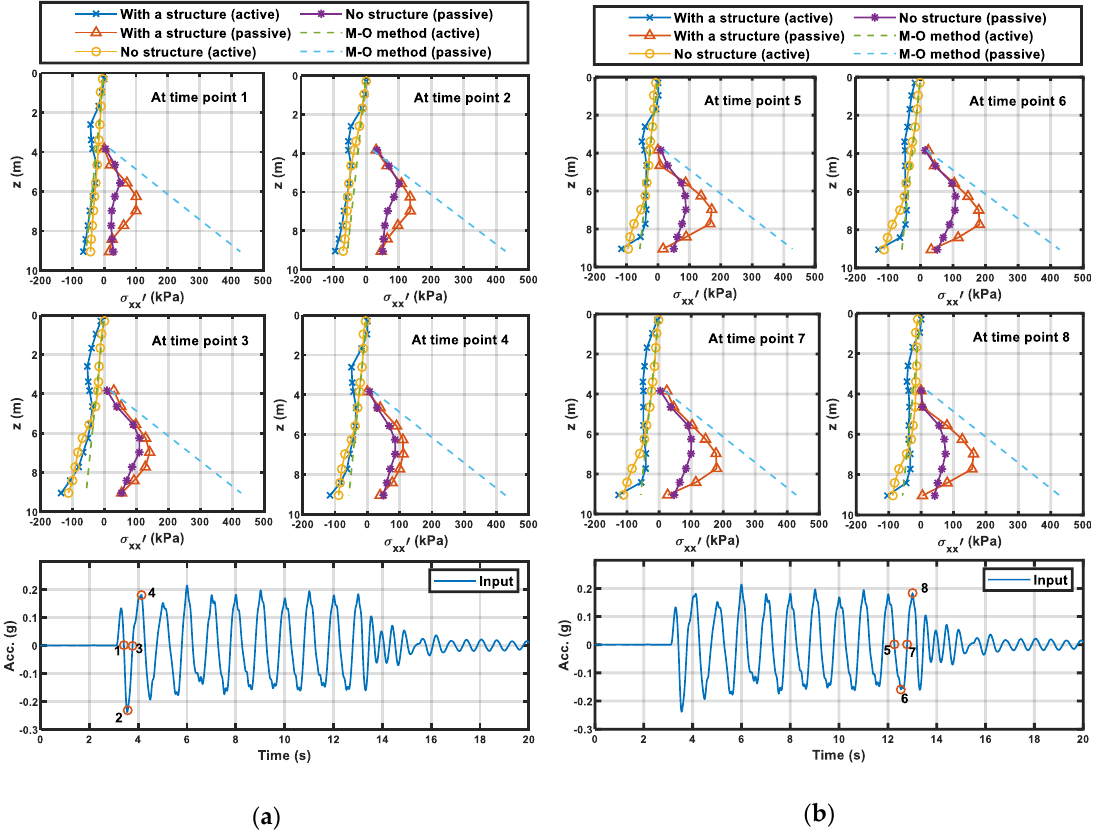
Figure 17. Evolution of the horizontal earth pressures through: ( a ) an earlier earthquake loading cycle and ( b ) a later earthquake loading cycle.